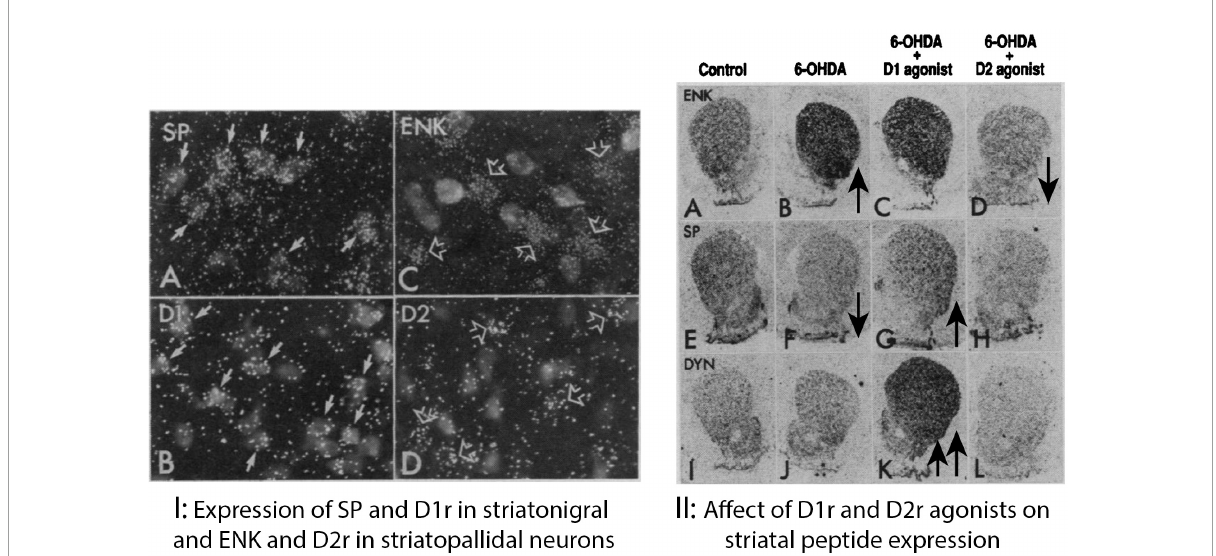
FIGURE2 (I) Expression of SP and D1 in striatonigral and ENK and D2r in striatopallidal neurons. Striatal neurons retrogradely labeled with the fluorescent dye fluorogold after injection into the substantia nigra combined with darkfield illumination of silver grains produced by ISHH labeling with 35S labeled oligonucleotide probes for (A) substance P (SP), (B) the DI dopamine receptor (DI), (C) enkephalin (ENK), and (D) the D2 dopamine receptor (D2). Striatonigral neurons show ISHH labeling for both substance P [ (A) , solid arrows] and the D1 dopamine receptor [ (B) , solid arrows]. Striatal neurons that are unlabeled by fluorogold, and presumably project to the globus pallidus, show ISHH labeling for both enkephalin [ (C) , open arrows] and the D2 dopamine receptor [ (D) , open arrows]. (II) In situ hybridization in the striatum from brain sections apposed to autoradiographic film labeled with 35S-labeled oligonucleotide probes complementary to (A–D) enkephalin (ENK), (E–H) substance P (SP), and (I–L) dynorphin (DYN). Sections in the first two columns are from the same saline-treated animal showing ISHH labeling on the unlesioned control side (A,E,I) and lesioned 6-OHDA-injected side (B,F,J) . Sections in the third column are from the lesioned, 6-OHDA-injected side of an animal that received intermittent treatment with the D1 receptor selective agonist SKF38393 (C,G,K) . Sections in the fourth column are from the lesioned, 6-OHDA-injected lesioned side of animal that received continuous treatment with the D2 agonist quinpirole (D,H,L) . The increase in enkephalin ISHH labeling caused by 6-OHDA lesions (B) is not affected by D1 agonist treatment (C) but is reversed by continuous D2 agonist treatment (D) . The decrease in substance P ISHH labeling caused by 6-OHDA lesions (F) is reversed by intermittent D1 agonist treatment (G) but is unaffected by D2 agonist treatment (H) . Dynorphin ISHH labeling is not significantly altered by 6-OHDA lesions (J) but is elevated by D1 agonist treatment (K) but not affected by D2 agonist treatment (L) (Gerfen et al.,